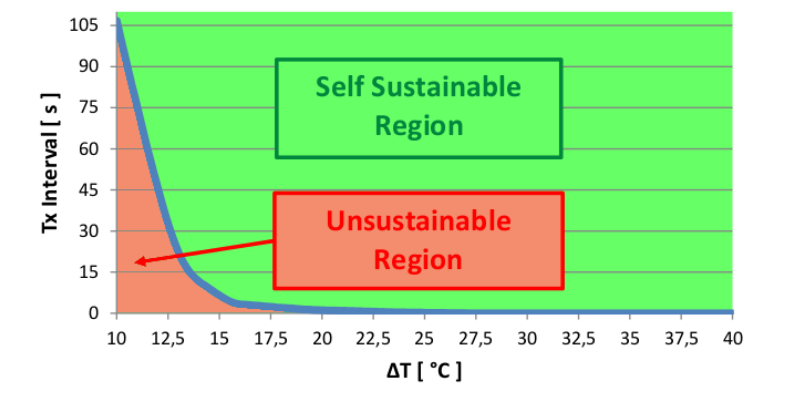
Figure 6. The Self-Sustainability curve represents the union of the points that separates the region of the plot where the nodes can operate autonomously from the region in which it fails to